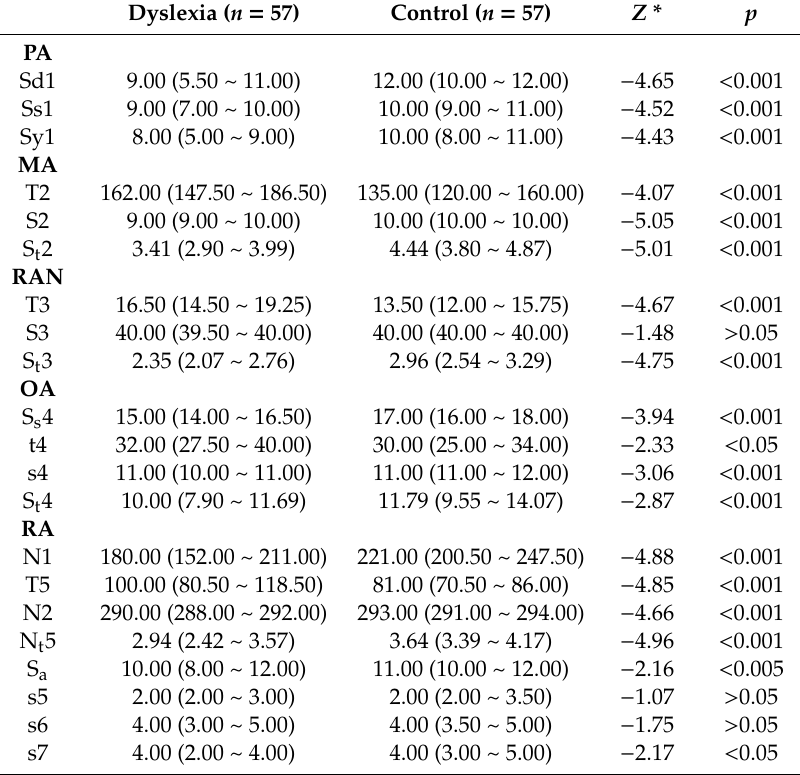
Table 3. Di ff erences of each subscale in the Chinese Reading Ability Test (CRAT) test between the dyslexia group and the control